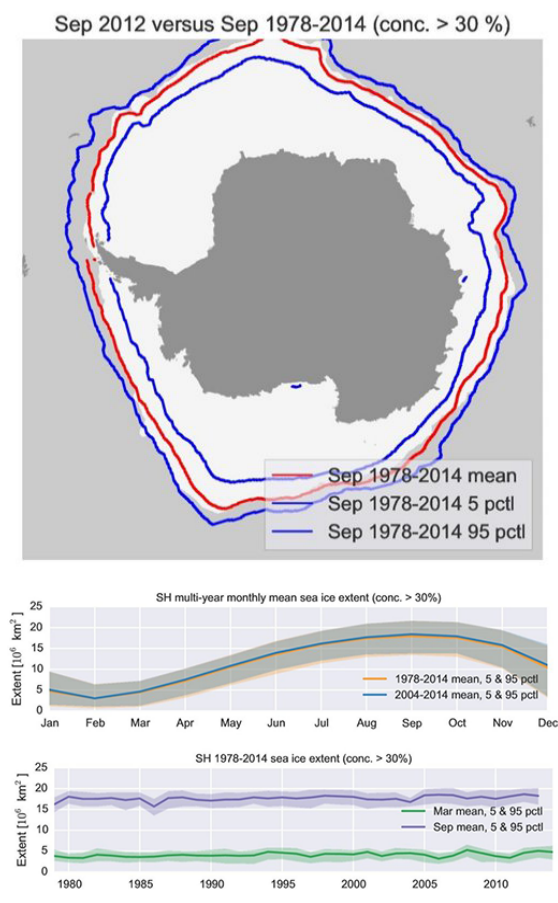
Figure 11. The upper panel: the September 2012 sea ice extent in the Antarctic compared to the mean extent shown with the red line. The blue lines on either side of the mean extent line are the 5 and 95 percentiles of ice extent. The lower two panels show the annual cy- cle of sea ice extent. The shaded areas are the 5 and 95% percentiles of the interannual and daily variability respectively. The lower panel show the long-term (1978–2014) Antarctic sea ice extent near its maximum in March and near its minimum in